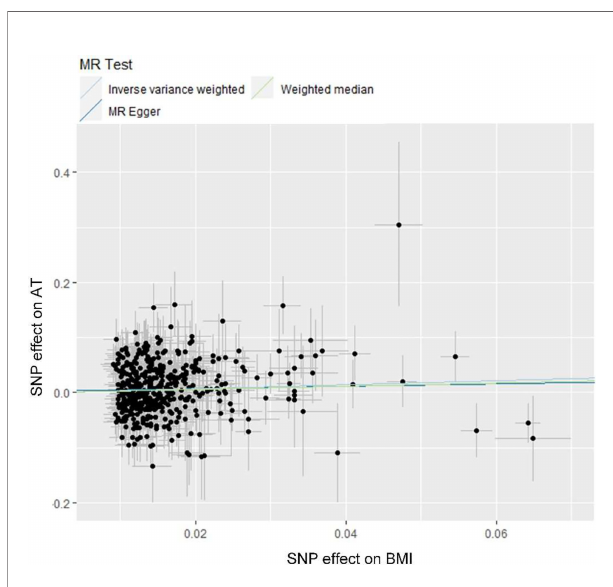
FIGURE 2 | Scatter plot showing the causal effect of BMI on AT. MR, Mendelian Randomization; BMI, body mass index; AT, Achilles